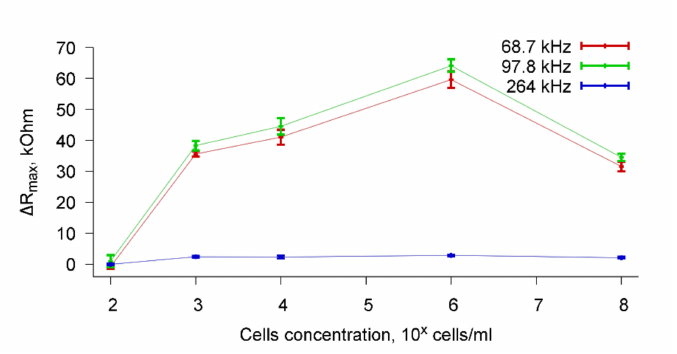
Figure 9. Dependencies of ∆ R max of the resonator on the concentration of the A. brasilense Sp7 cells for resonance peaks near the frequencies 68.7, 97.8, and 264 kHz where x is power. The concentration of antibodies was 4 µ g /